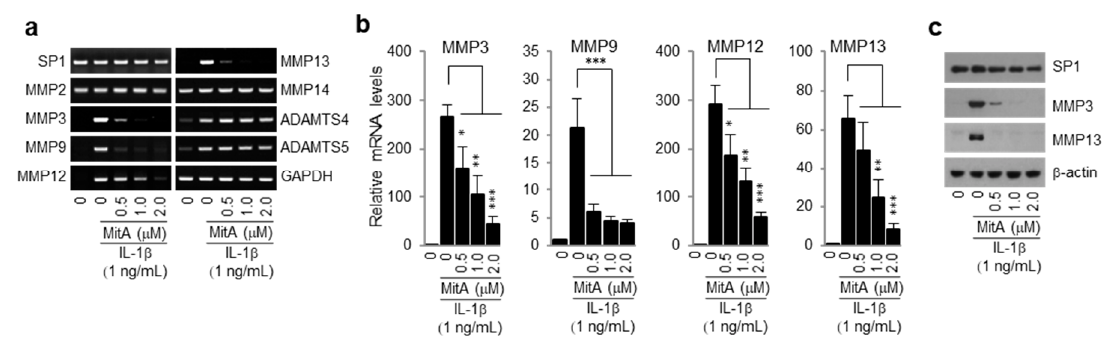
Figure 1. Mithramycin A (MitA) inhibits IL-1 β -induced expression of matrix-degrading enzymes in mouse primary chondrocytes. ( a , b ) mRNA expression levels of indicated genes were detected in chondrocytes treated with IL-1 β alone or treated with IL-1 β and MitA for 24 h. Representative images of RT-PCR ( a ) and quantification using real-time PCR ( b ) are shown ( n = 5). Values are means ± SEM (* p < 0.05, ** p < 0.01, *** p < 0.001); ( c ) Protein levels of SP1 (cellular) and MMP3/MMP13 (extracellular) were determined by Western blotting.